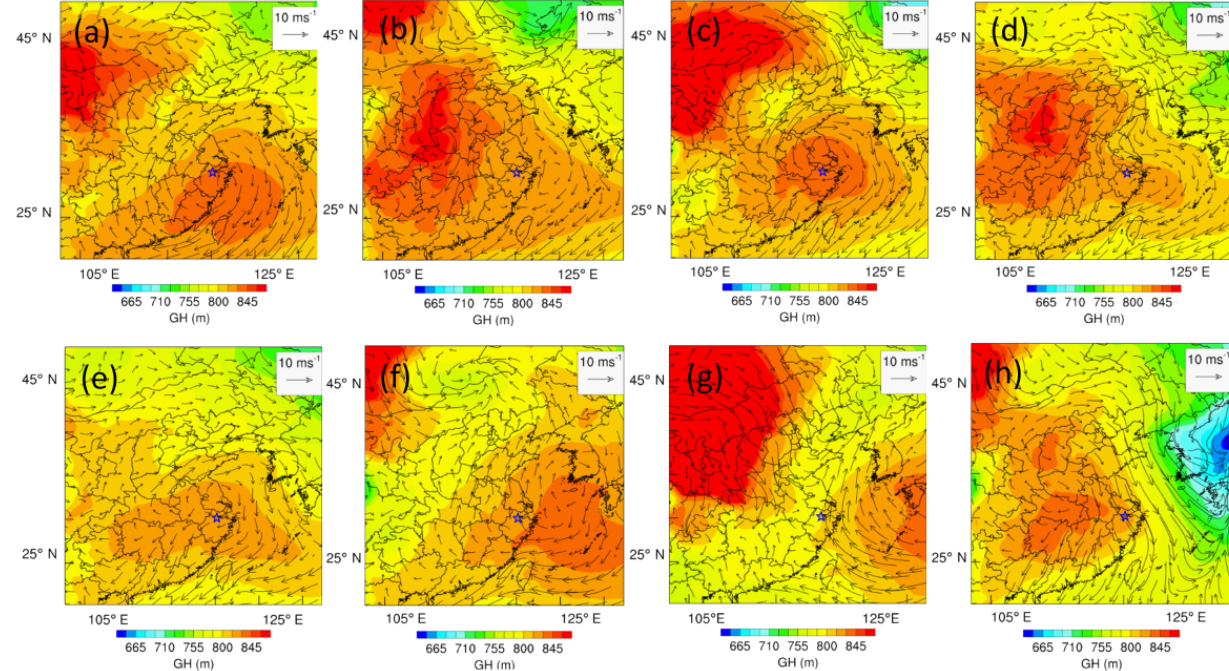
Figure 9. The geopotential height field (GH) (indicated by color bars) and wind field (WF) (black vectors) for 925hPa at 20:00LT during 2–9 December 2013. All panels represent 2–5 and 6–9 December from left to right on the top and bottom. The NRCS is marked by the